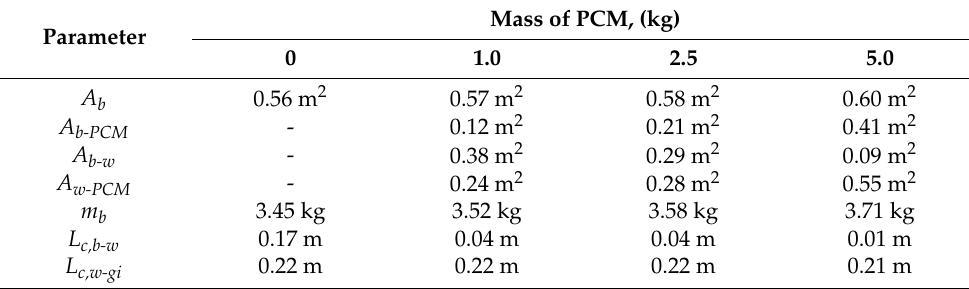
Table 4. Input parameters for the mathematical modeling—dependent on the mass of PCM.